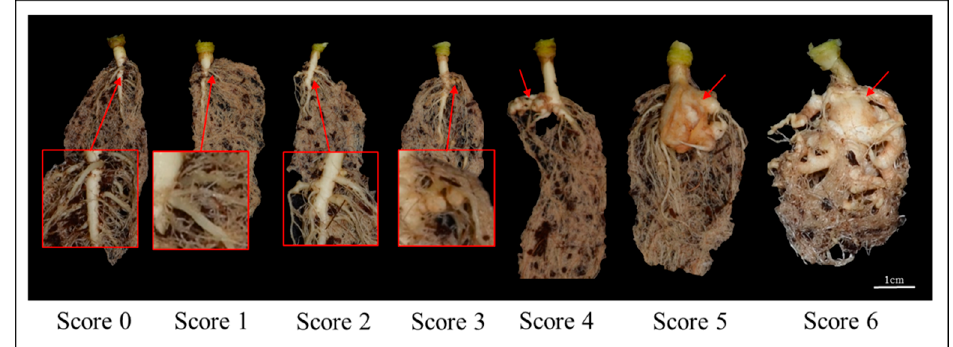
Figure 1. The clubroot disease symptom of roots infected by Plasmodiophora brassicae , and the standard of evaluation depending on the severity of root morphology modification. The disease symptom of roots infected and standard of evaluation depending on the severity having lump formation named as club. Symptom was classified on 7 scales from 0 to 6, where 0 = no symptoms; 1 = very slight swelling, usually confined to lateral root; 2 = a few tiny globular nodules on the lateral roots; 3 = several small-sized nodules on lateral roots; 4 = large clubs on lateral roots joining together to form a lump and slight swelling of main roots; 5 = large clubs on main roots; 6 = severe clubs (lumps) formation all over roots and complete change of root morphology.